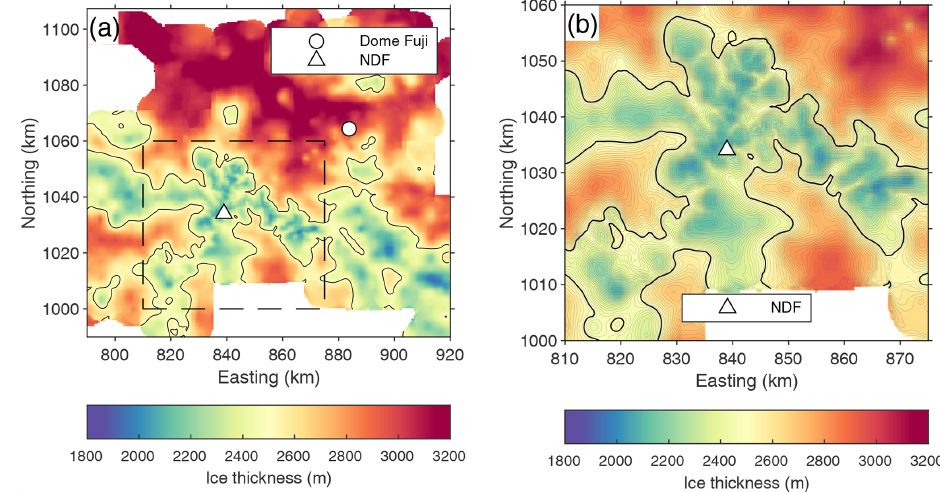
Figure 9. The gridded ice thickness in (a) the study region and (b) the JARE60 observational area. The box in (a) indicates the area shown in (b) . The bold contours indicate an ice thickness of 2500m. The thin contours in (b) indicate ice thickness with intervals of